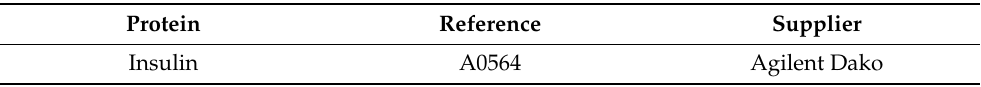
Table 3. List of antibodies used for